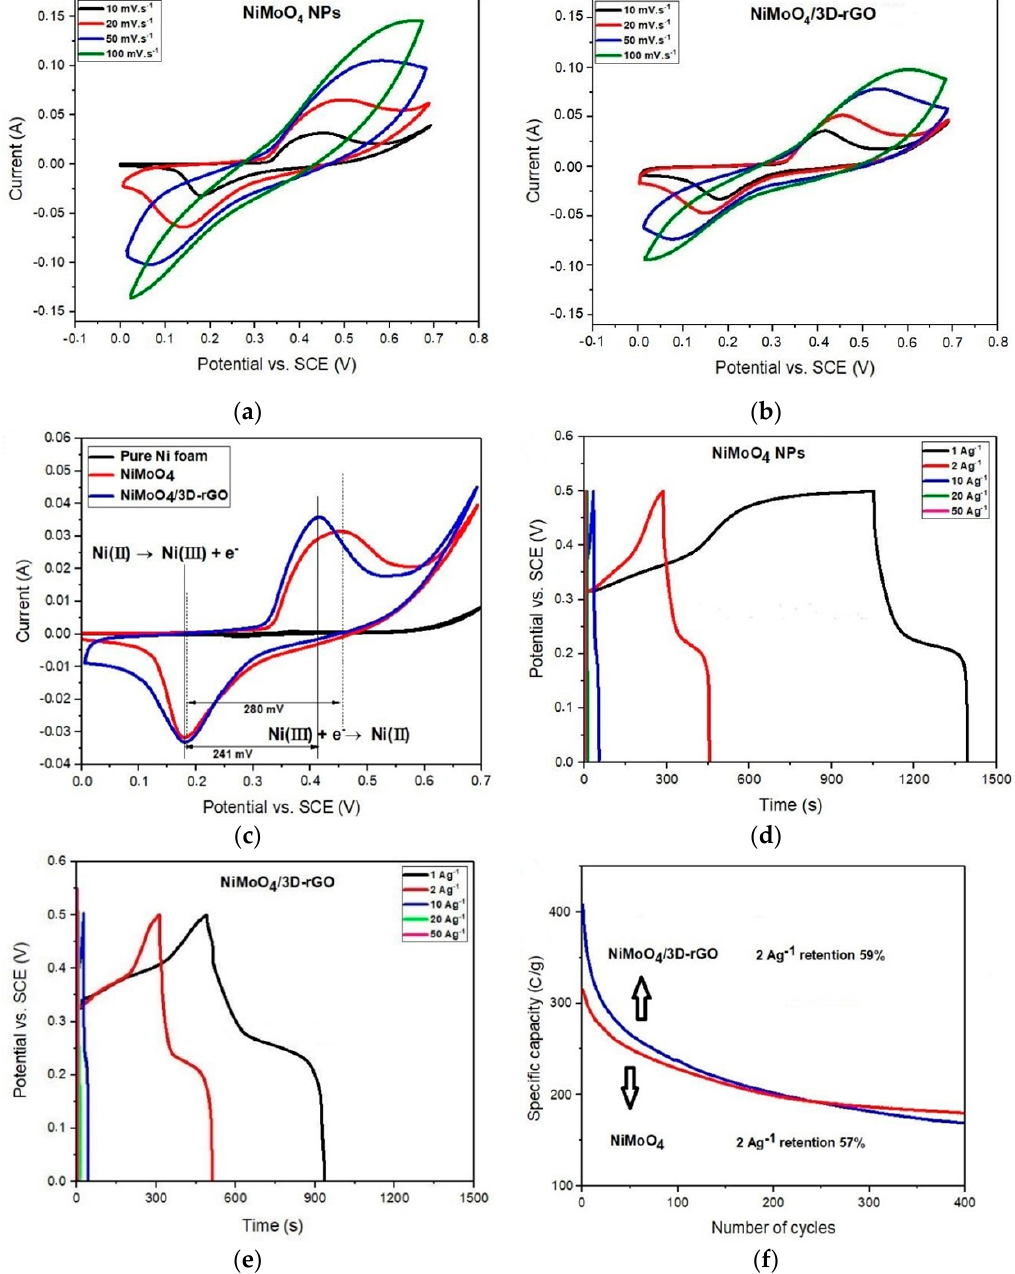
Figure 6. Cyclic voltametry curves of ( a ) pure NiMoO 4 NP electrode and ( b ) hybrid NiMoO 4 /3D-rGO electrode at various scan rates (10–100 mV·s − 1 ); ( c ) CV curves of Ni foam, NiMoO 4 NPs, and NiMoO 4 /3D-rGO electrode (10 mV·s − 1 ); Galvanostatic charge discharge curves of ( d ) pure NiMoO 4 NPs electrode and ( e ) hybrid NiMoO 4 /3D-rGO electrode at different current densities (1–50 A g − 1 ); ( f ) age test of hybrid NiMoO 4 /3D-rGO and pure NiMoO 4 NPs electrode at a current density of 2 A g − 1 .